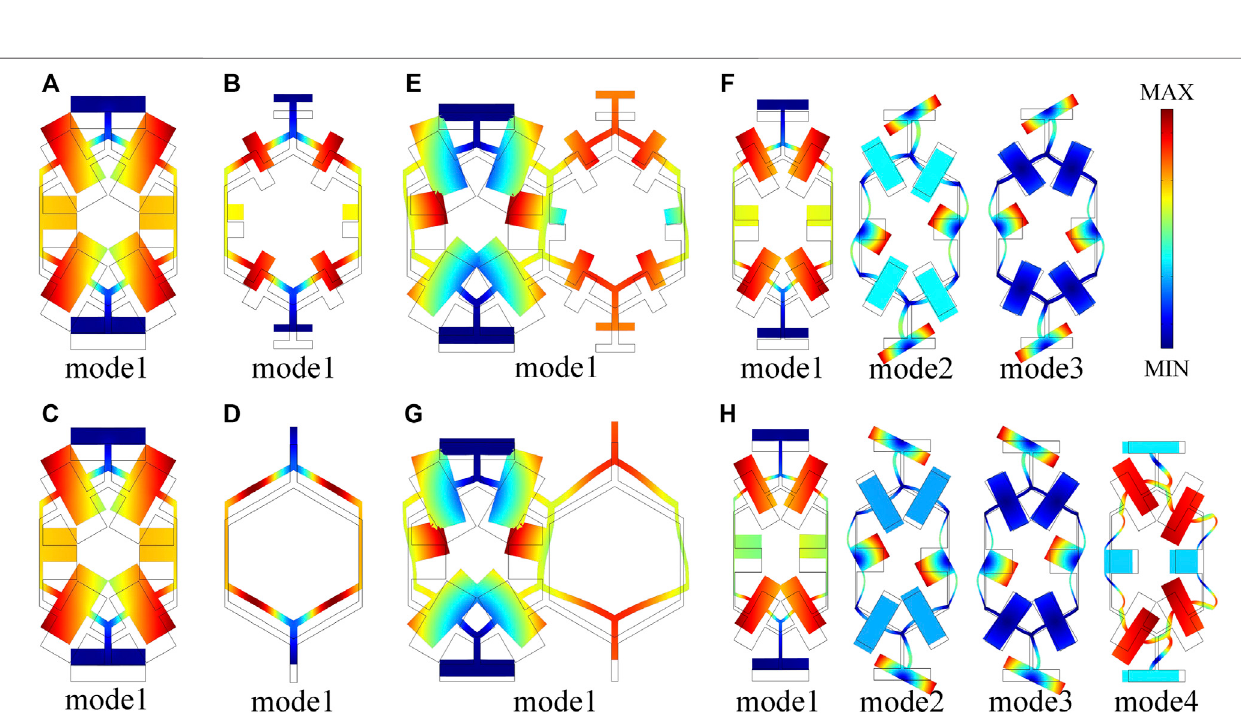
Frontiers in Materials |